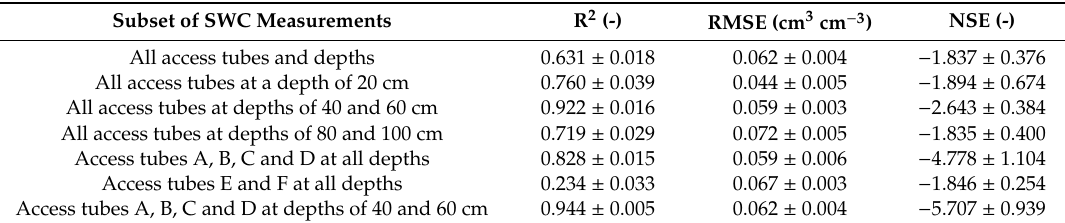
Table 4. Summary of the fit between soil water content (cm 3 cm − 3 ) measured using neutron probes in 2018 and HYDRUS-3D simulations using soil hydraulic parameters obtained from Rosetta.